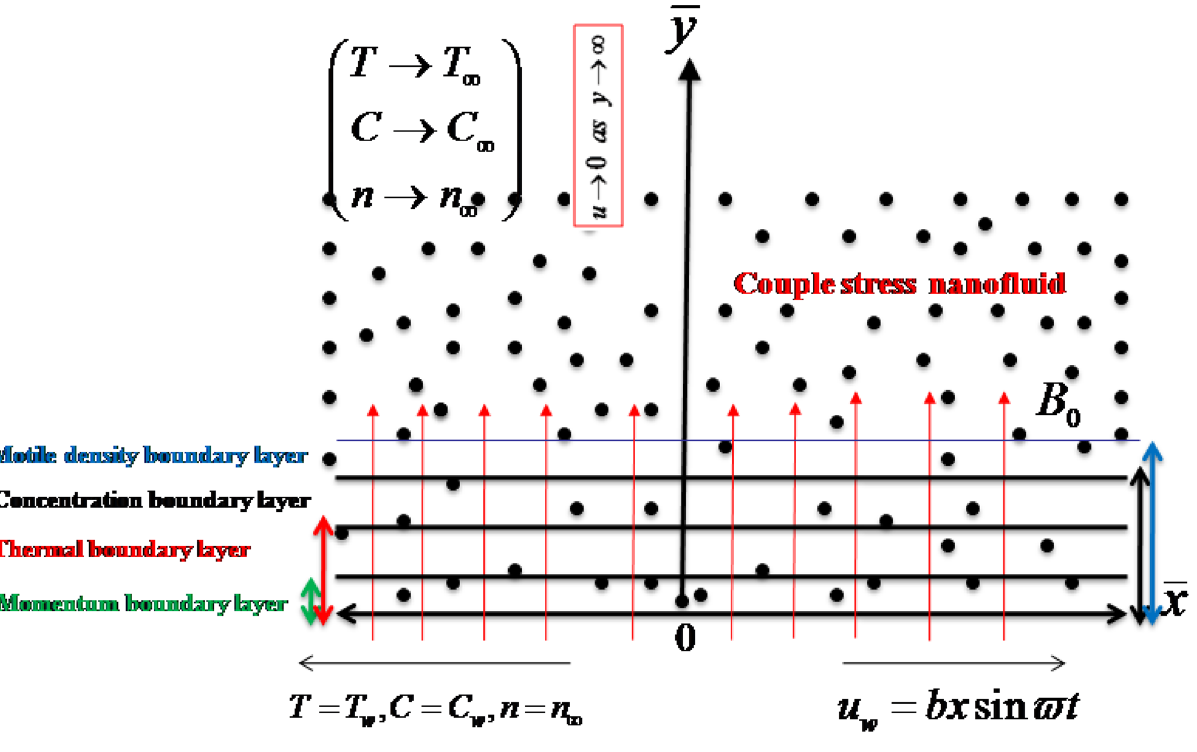
Figure 1. Geometry of flow